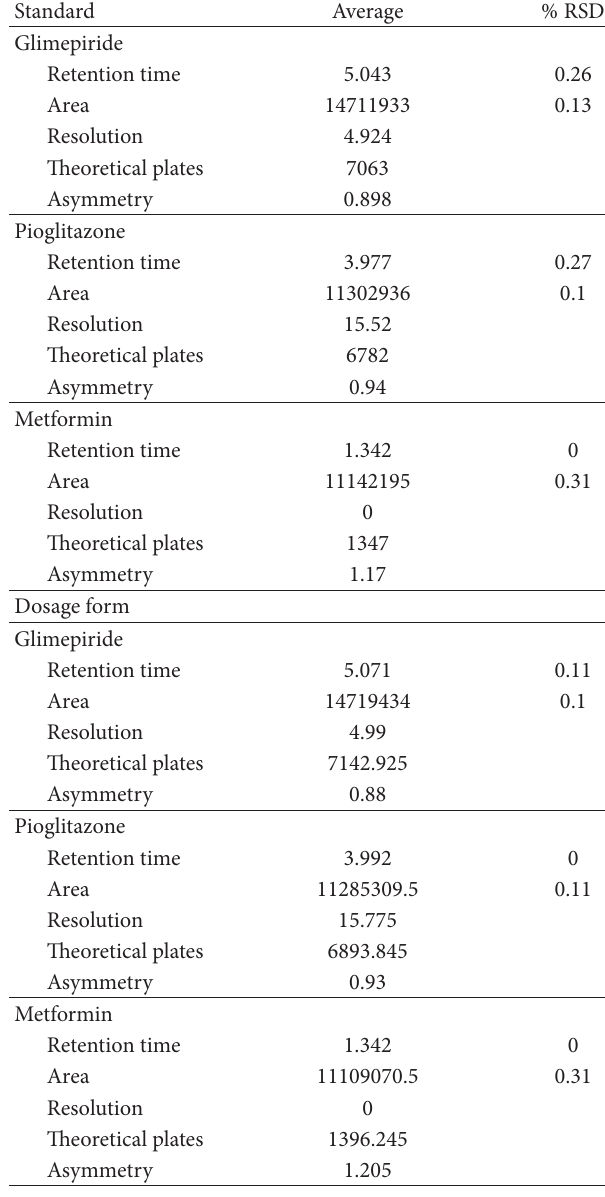
T 1: System suitability